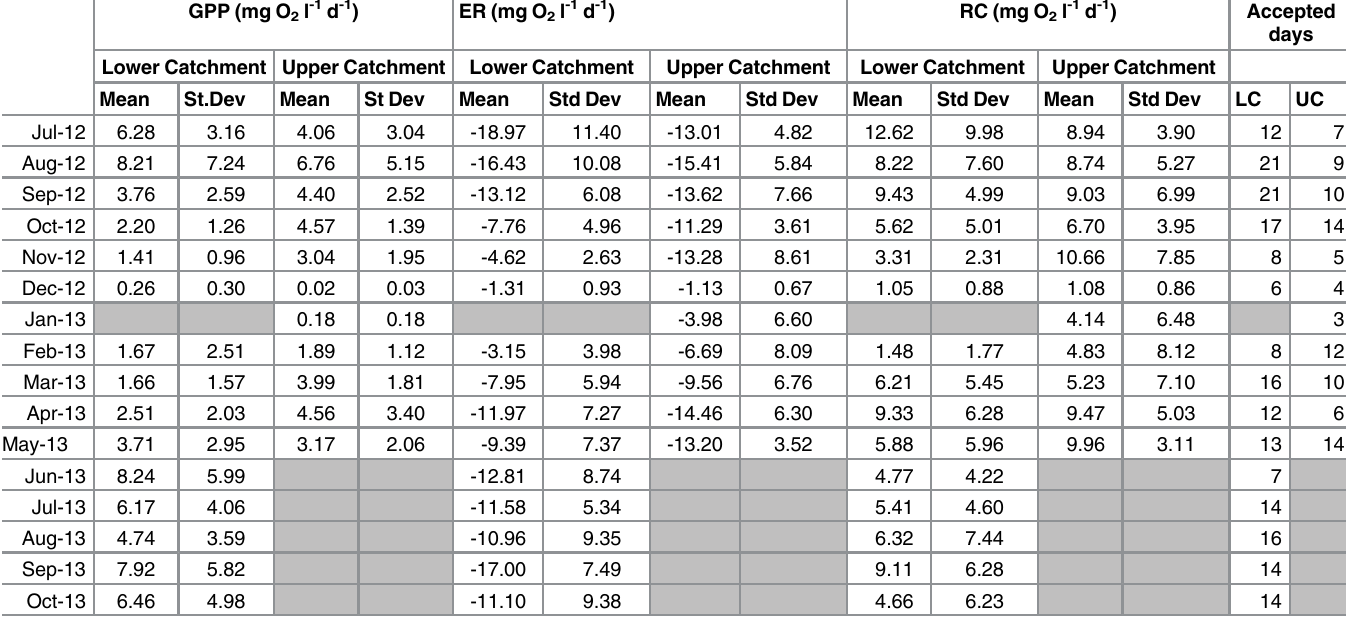
Table 3. Comparisons of the average and standard deviation of the daily gross primary productivity (GPP), ecosystem respiration (ER) and re-aer- ation (RC) for each month for both the lower and upper catchment. Both downstream loggers chosen at each location LC2 (lower catchment) and UC2 (upper catchment). The number of daily accepted models is also included at the right hand side of the table. Shaded areas represent periods where there is no data due to equipment malfunction. GPP (mg O 2 l -1 d -1